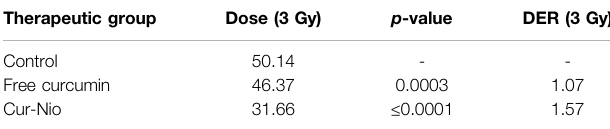
TABLE 3 | Comparison of dose enhancement ratios (DER) between the free curcumin and Cur-Nio at a single dose of 3 Gy after 72 h. Therapeutic